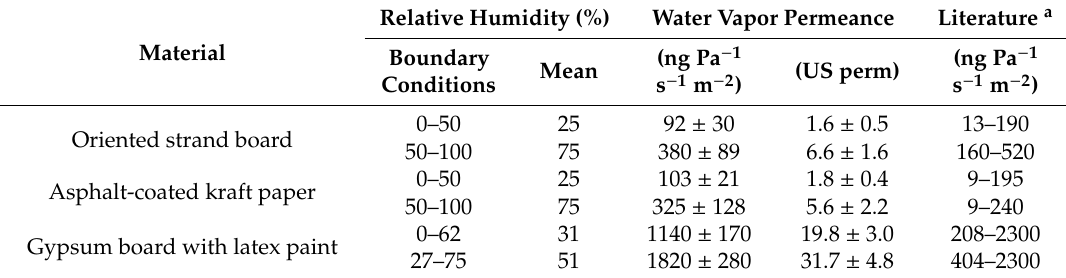
Table 2. Water vapor permeance measurements and literature